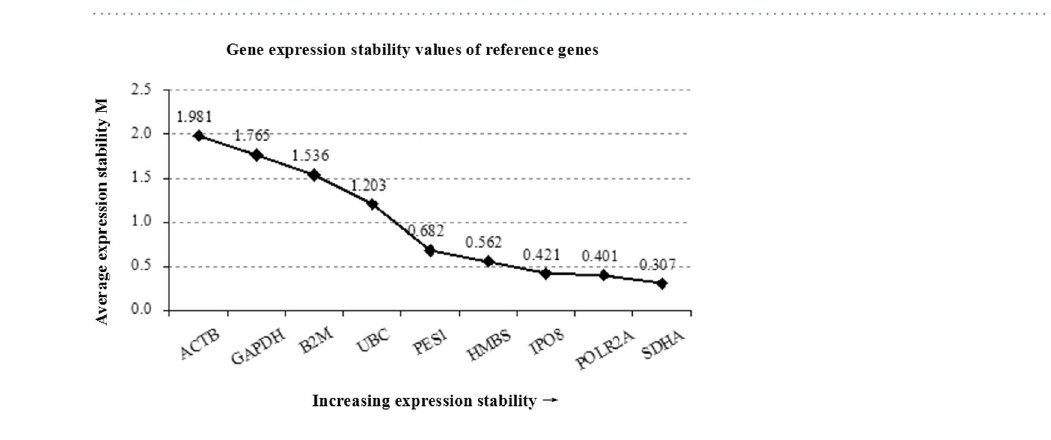
Figure 1. Average expression stability values (M). Expression stability values of genes from the least stable (left) to most stable (right).